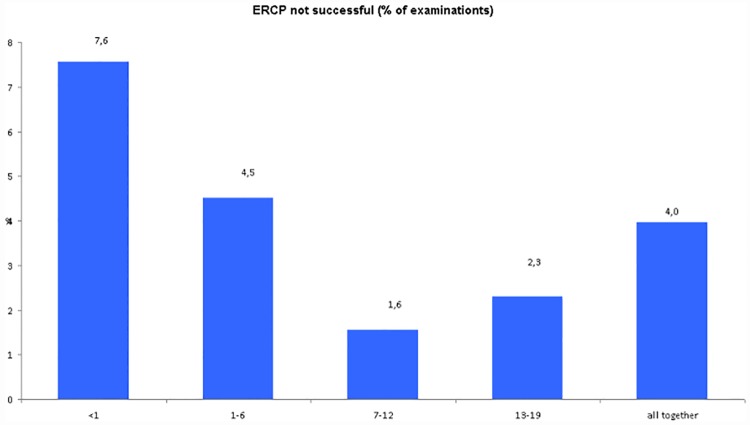
ERCP not successful (%).